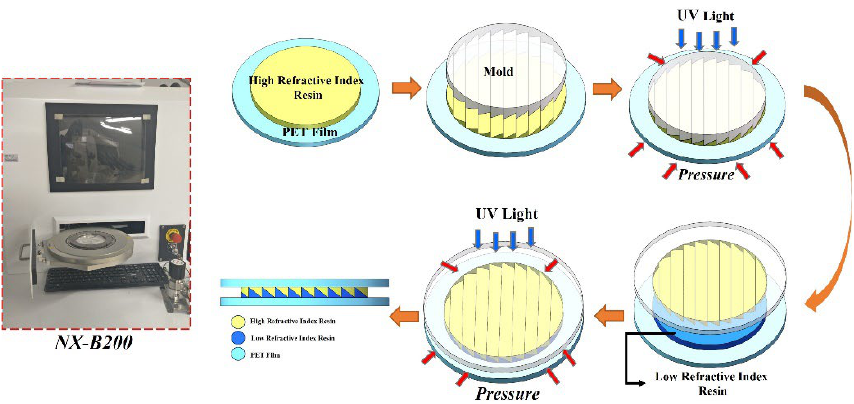
Figure 5. Process diagram of preparing ARCs film using